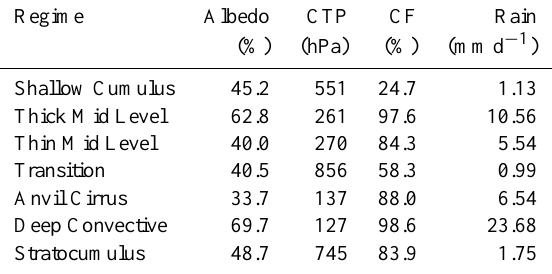
Table 1. Cloud regimes used in this study, from Gryspeerdt and Stier (2012). The mean rain rate is an annual mean over the tropics (30 ◦ N–30 ◦ S) from the Global Precipitation Climatology Project (GPCP) 1 ◦ product (Huffman et al.,